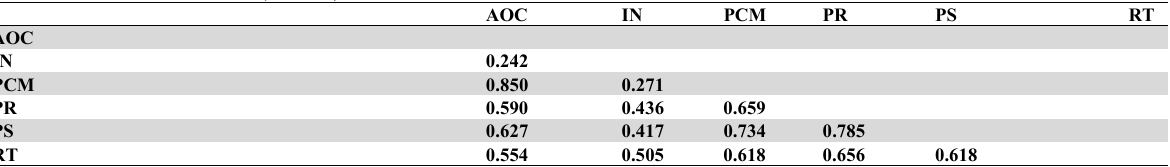
Heterotrait-Monotrait Ratio